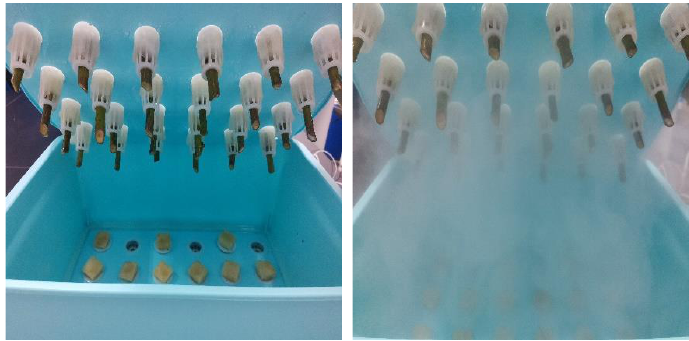
Figure 3. Aeroponics rapid propagation experiment.